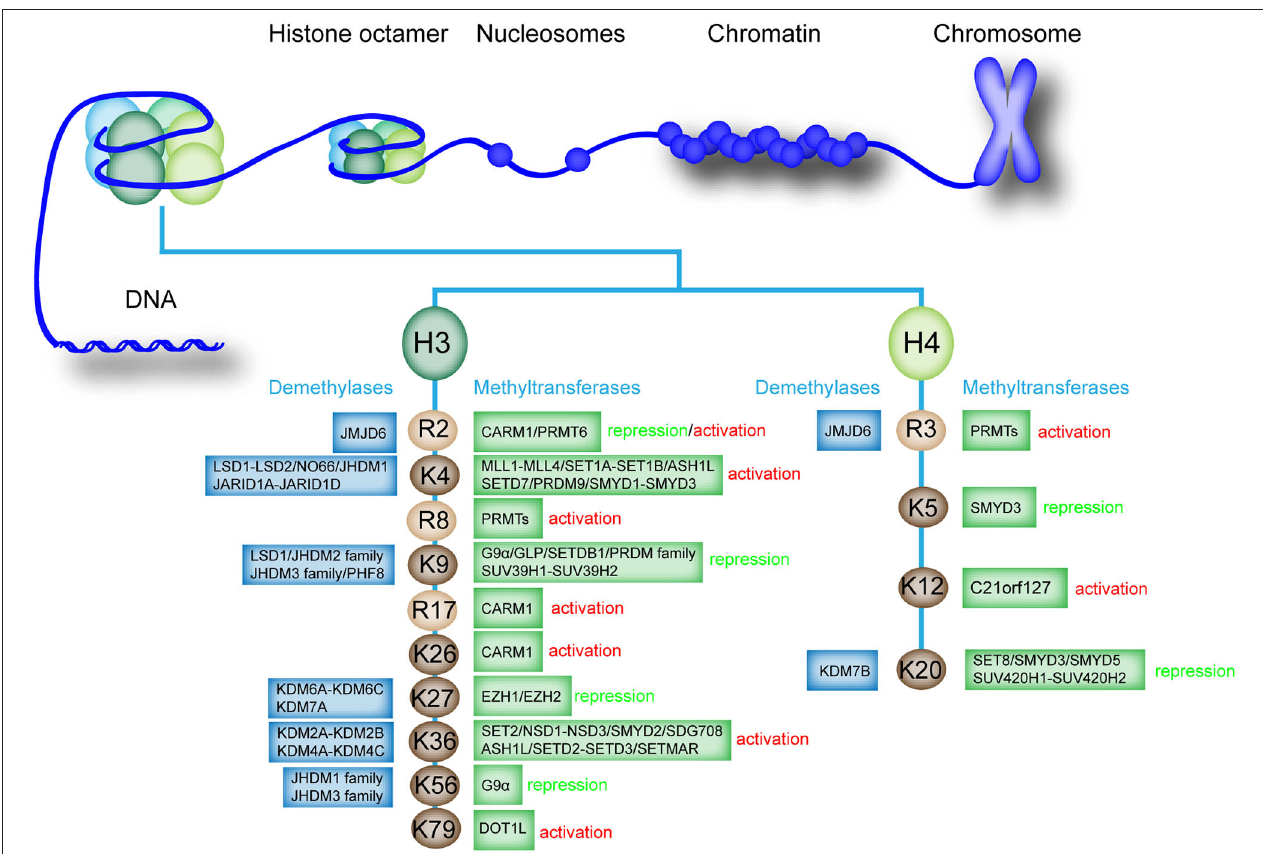
FIGURE 1 | Existing methylation sites in histones, the enzymes involved, and the effects on the transcription of downstream genes. The existing methylation sites and the histone methyltransferases and demethylases that catalyze monomethylation, dimethylation, trimethylation, or demethylation are listed. The effect of methylation modification at each site on downstream gene transcription is labeled as “activation” or